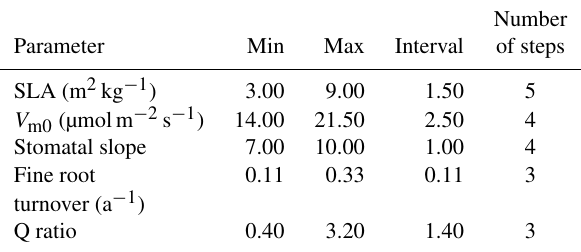
Table 5. Minimum value, maximum value, interval size, and num- ber of steps for each parameter used in